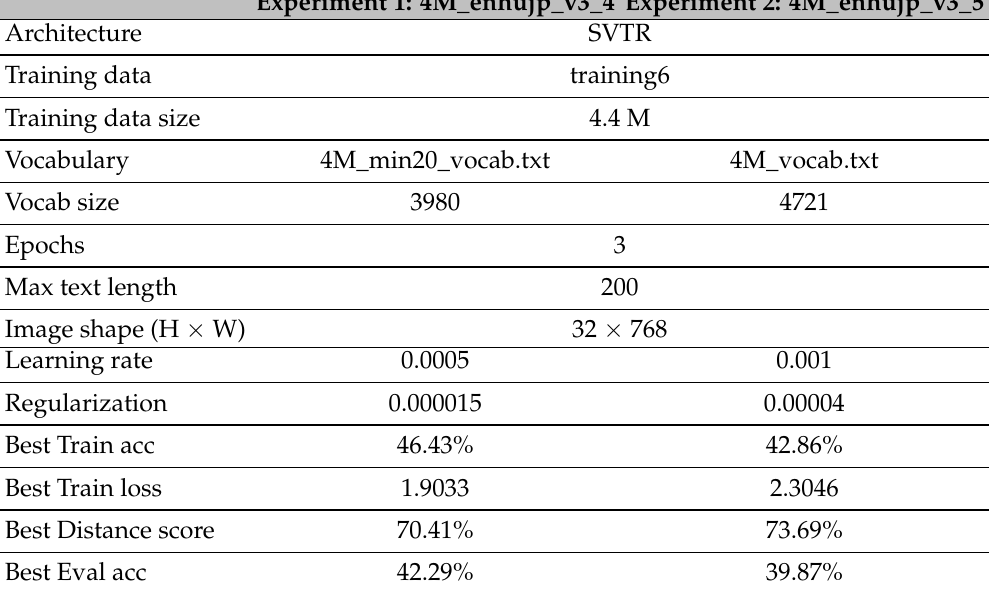
Table 9. Multilanguage Experiments: 1 and 2.